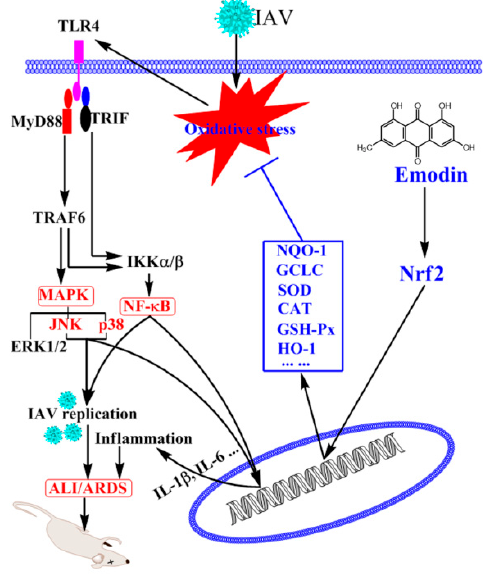
Figure 8. Potential mechanism of emodin to inhibit IAV replication and IAV viral pneumonia. Emodin activates Nrf2 signaling pathway, enhances the production of NQO1, GCLC, SOD, CAT, GSH-Px and HO-1 and suppresses IAV-mediated oxidative stress, which further inhibits IAV-induced activations of TLR4, p38/JNK MAPK and NF- κ B pathways, leading to suppression of IAV replication and inflammatory cytokine productions and finally improving IAV-induced ALI/ARDS.